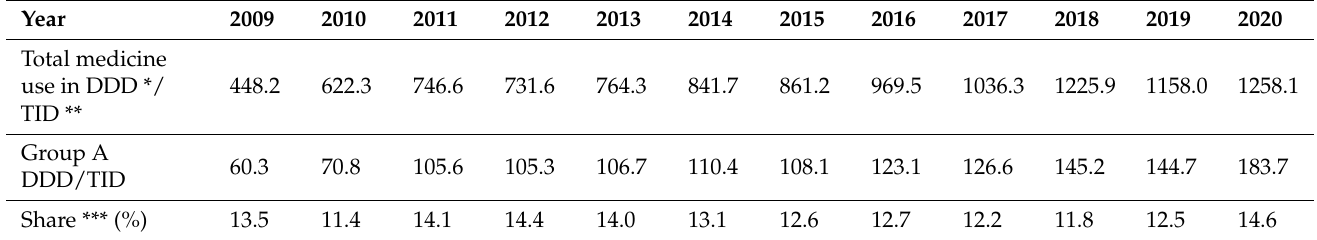
Table 1. The utilisation of medicines acting on the alimentary tract and metabolism (group A according to ATC classification) expressed in DDD/TID and as a share (%) of the total